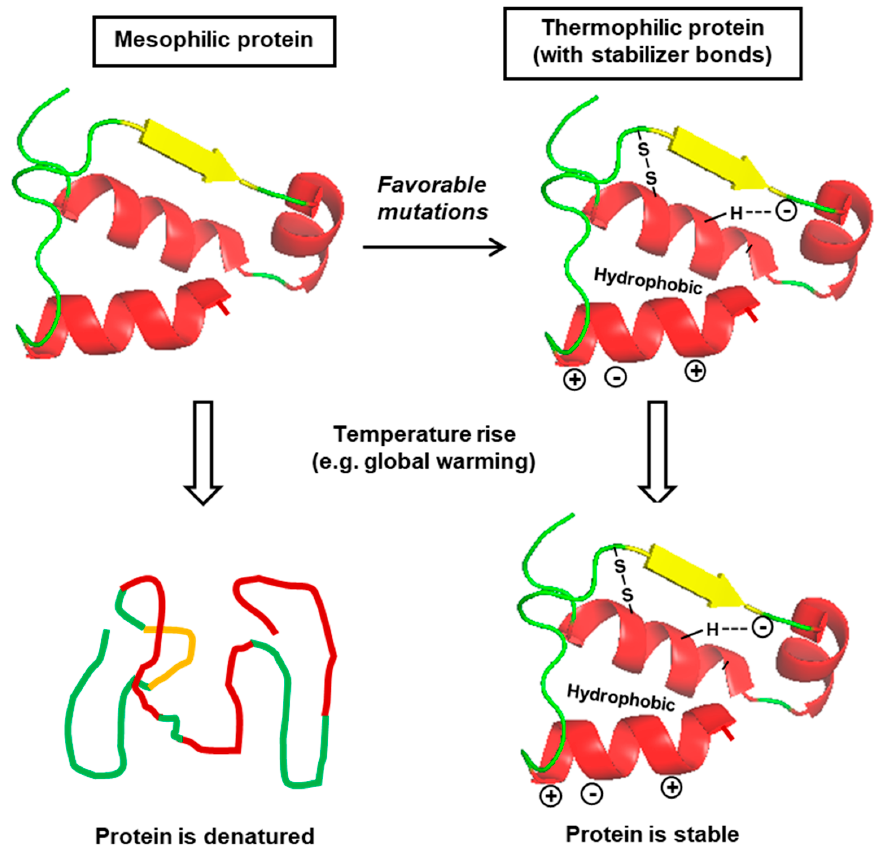
Figure 4. Diagram of the major consensus features for thermal stability in protein structure: disulfide and hydrogen bonds, charge–charge interactions on the exterior, and hydrophobic interactions in the interior (details in Section 3). These interactions stabilize the protein against inactivation/denaturation at high temperature. The secondary structural elements are color-coded, as in Figure 3.